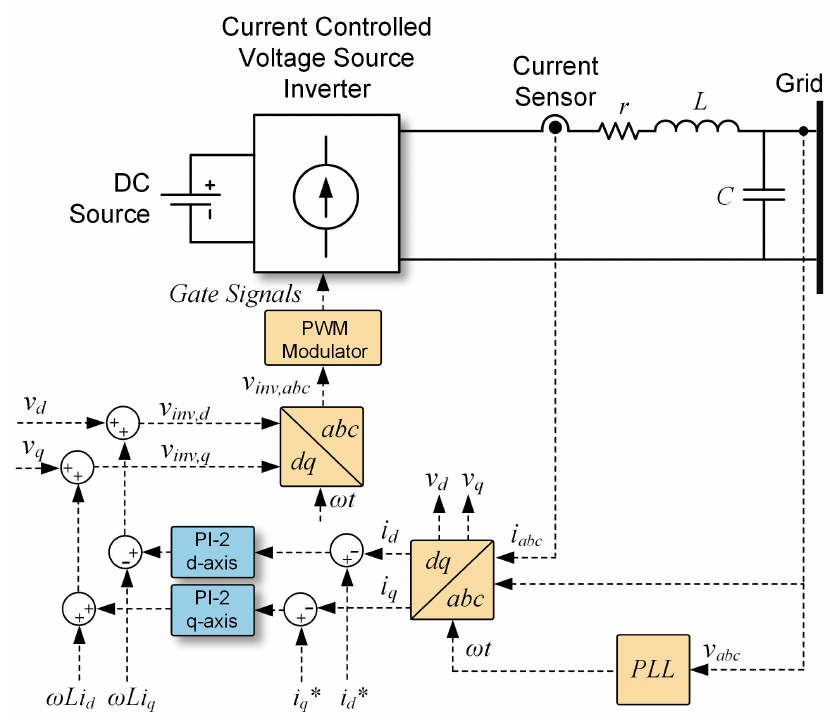
Figure 2. Schematic diagram of the grid-connected inverter benchmark and PI (proportional-integral) Type-2 based current controller; PLL: Phase Locked Loop; PWM: Pulse Width Modulation; “*” represents the reference values of the